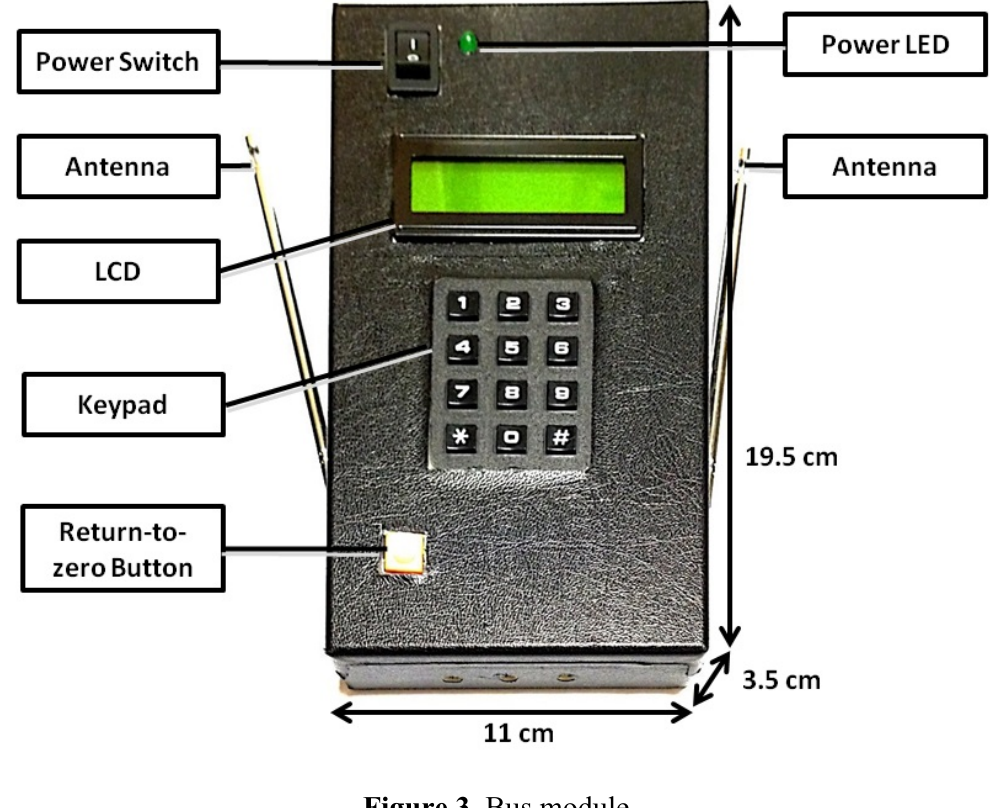
Figure 2. User module.